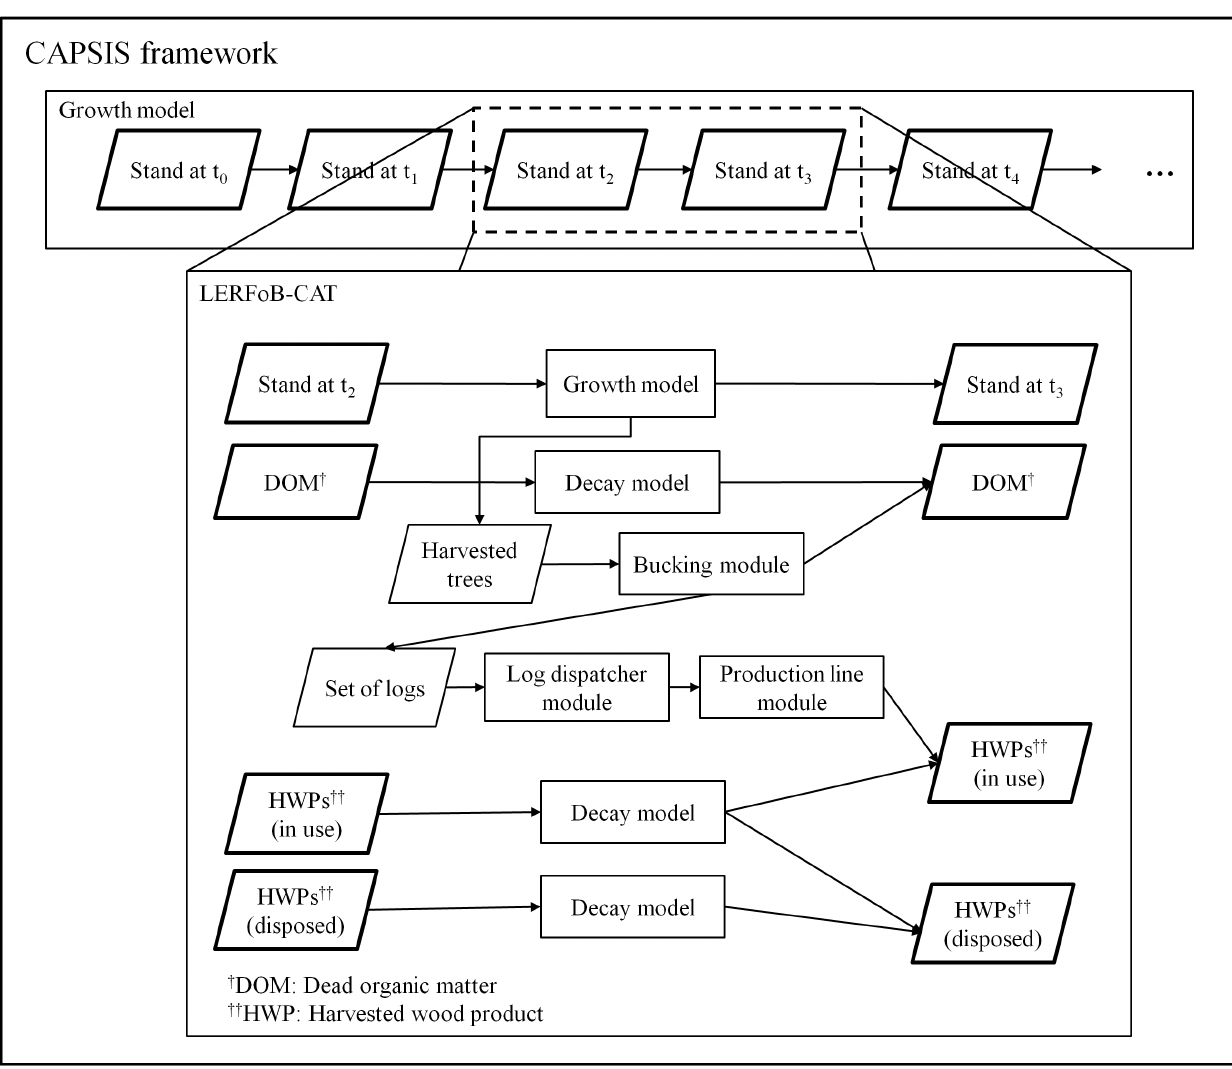
Figure 1. Coupling of a growth model and the carbon assessment tool (LERFoB-CAT) within the CAPSIS framework (adapted from Fortin et al .